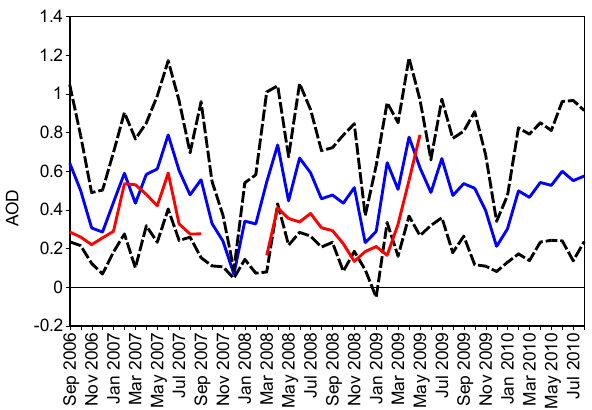
Fig. 7. Monthly variation in AOD (at 340nm) at Uccle (based on data from September 2006 until the end of August 2010). The blue line is the mean seasonal value, whereas the dashed black lines rep- resent the mean value ± its standard deviation. For December 2007, the mean monthly value is based on only 3 individual AOD values (which were accidentally very close). This explains the low stan- dard deviation for this month. The AERONET level 2.0 monthly means are shown in red.